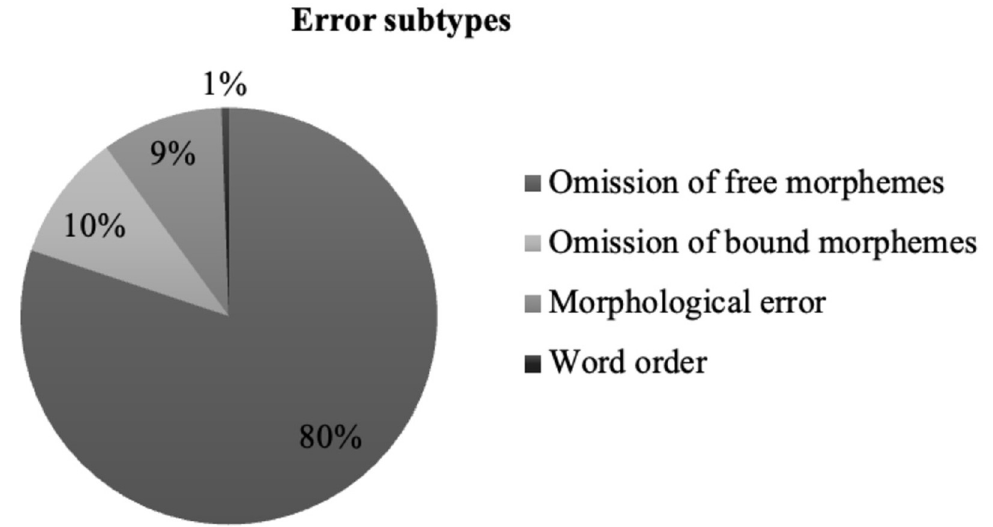
Fig 3. Distribution of error subtypes.